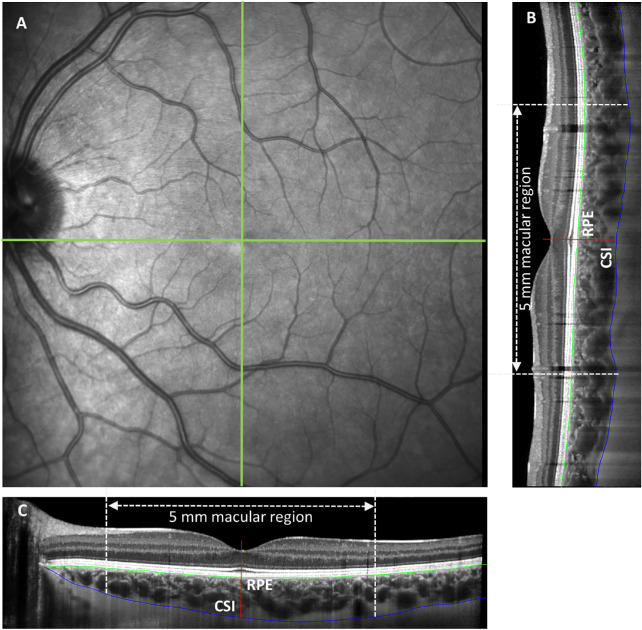
The en-face retinal (A) and the vertical (B) and horizontal (C) B-scan images of a representative subject demonstrating the cross-line enhanced depth imaging OCT scan protocol used in this study (green lines in A), the position of the fovea at the deepest location of the foveal pit manually marked in the custom-written software (red line in B and C), the anterior (green line in the vertical and horizontal B-scan images) and posterior (blue line in the vertical and horizontal B-scan images) boundaries of the choroid, and the central 5-mm macular region across which the thickness of the choroid was averaged. RPE, retinal pigment epithelium; CSI, chorioscleral interface.